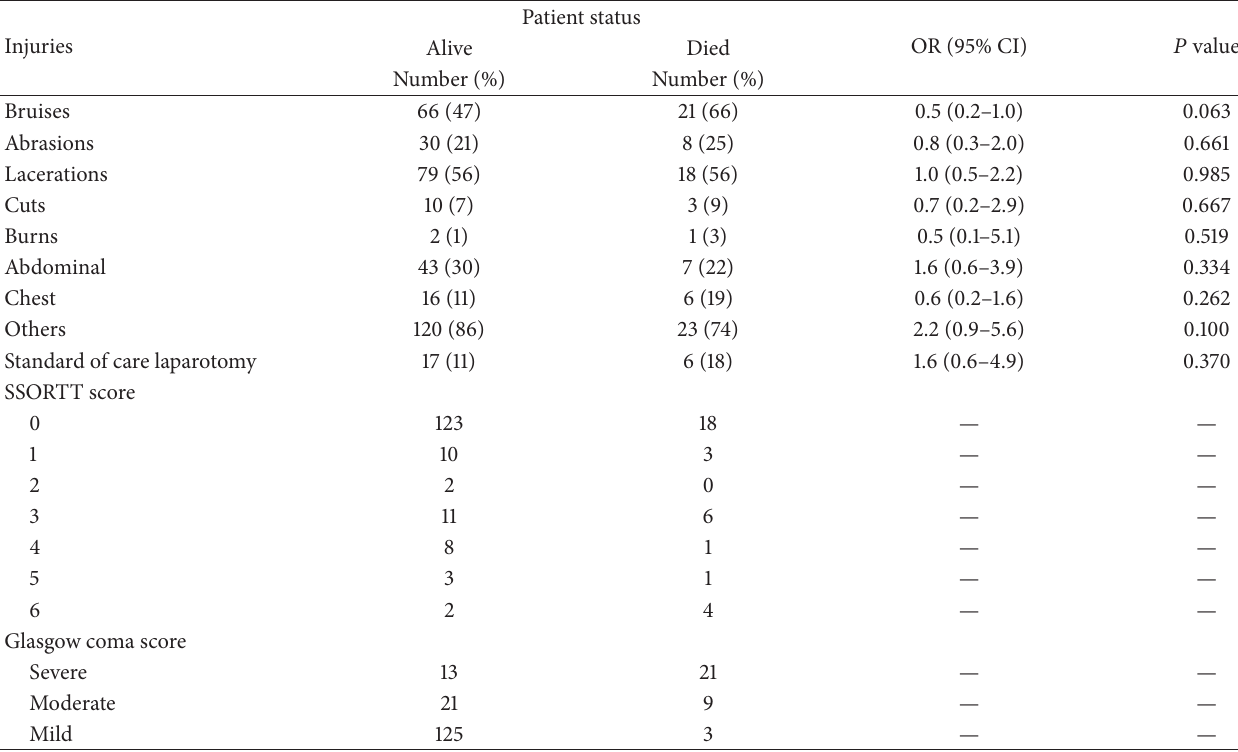
Table 3: Comparison of the fatalities and